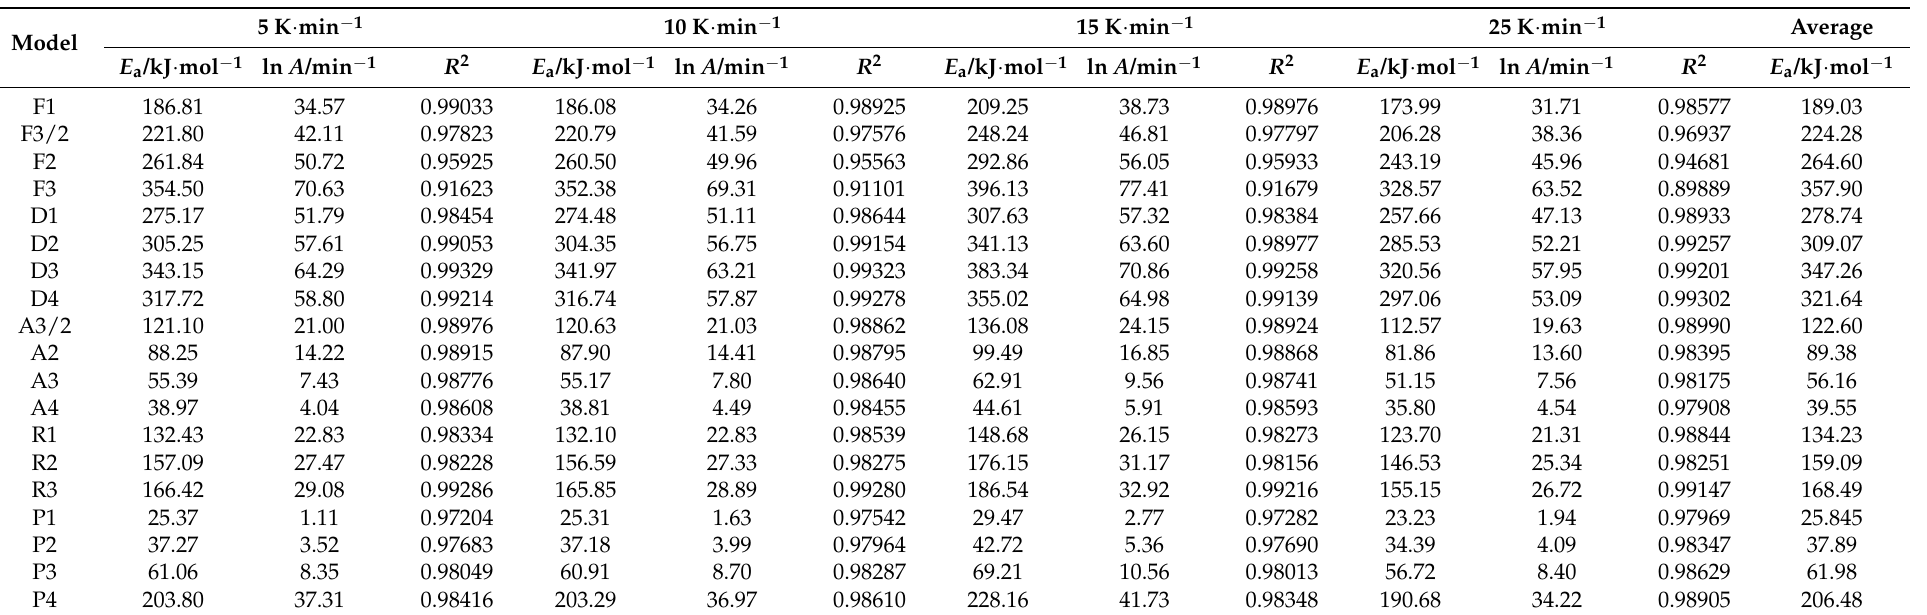
Table A5. The kinetic parameters of the first pyrolysis stage of NOC calculated by KC method at different heating